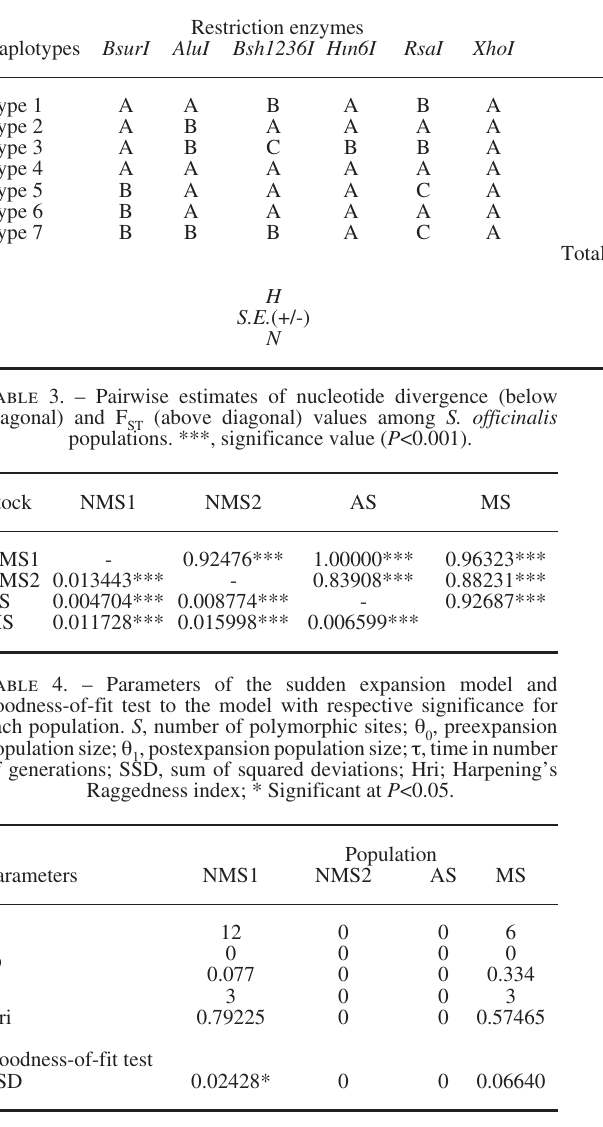
Table 2. – Frequency of 7 composite mtDna haplotypes from rFlP data within the studied stocks of S. officinalis . letters reflect individual haplotypes for six restriction enzymes; Bsuri, alui, Bsh1236i, Hın6i, Rsai, Xhoi (left to right). H , haplotype diversity; n, nucleotide diversity; S.e ., standard error.